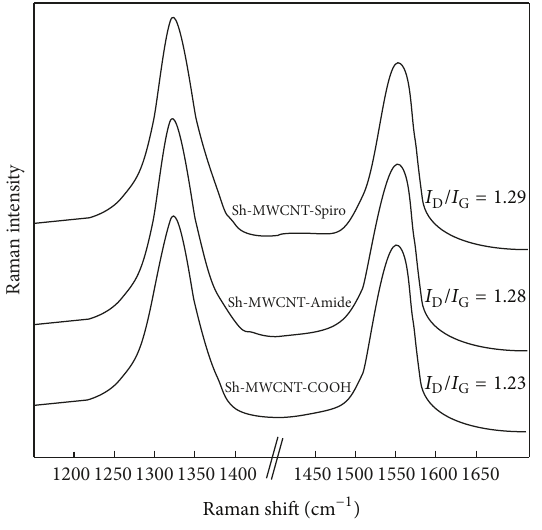
Figure 5: The Raman spectra of modified Sh-MWCNTs. The base- line was corrected for the luminescence background.